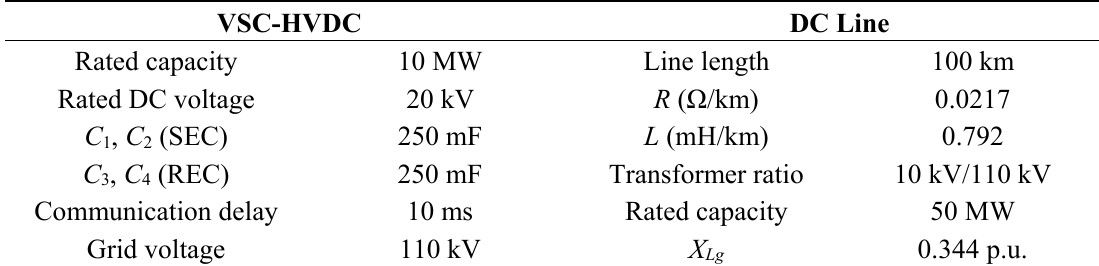
Table A2. Parameters of VSC-HVDC and DC